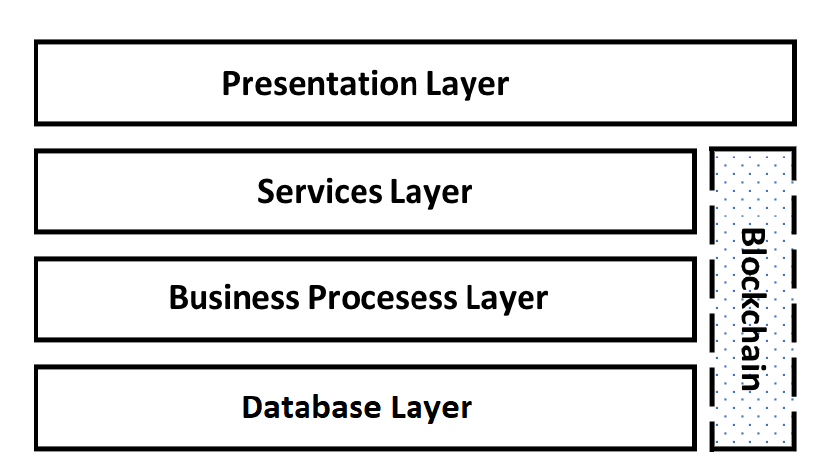
Figure 1: Layered architecture for a Blockchain-enabled QMS